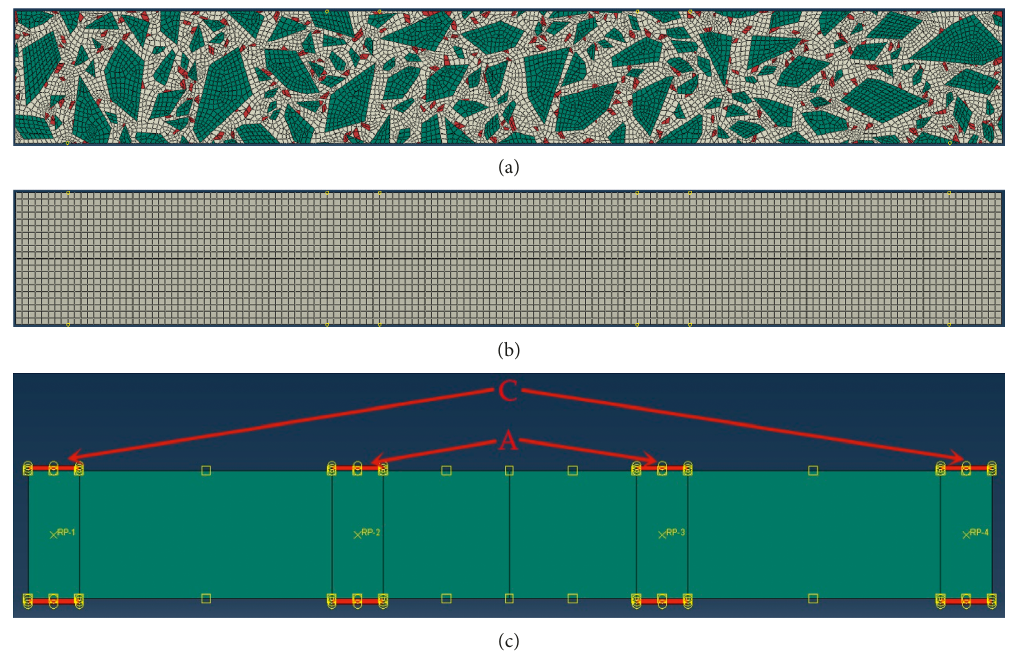
Figure 3: FEM modelling: (a) asphalt mixture sample; (b) asphalt mortar; (c) clamps.